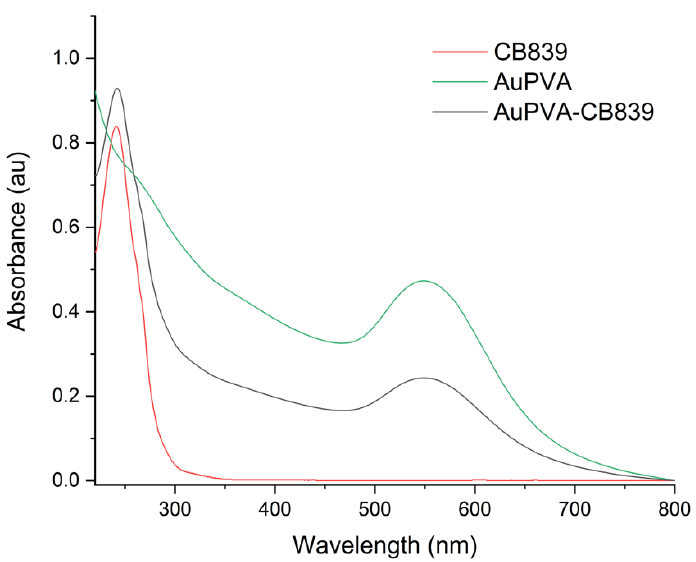
Figure 4. UV-VIS spectra of CB839 (red), AuPVA (green), and AuPVA-CB839 NPs (black). Using energy-dispersive X-ray spectroscopy (EDX), elemental maps of AuPVA- CB839 NPs were collected on a scanning transmission electron microscope (STEM). The elements gold, corresponding to the AuPVA NPs and fluorine from CB839 are displayed in maps in Figure 5. Here, fluorine appears to be in the same area as gold and to form similar circular patterns correlated with the Au map. Since electrons scatter strongly from Au, the contrast in the fluorine (F-K) X-ray map is likely caused by an increase in the Bremsstrahlung background. In order to confirm the presence of F in the vicinity of Au NPs and to observe the influence of background radiation, X-ray spectra taken on Au NPs were compared against such taken from surrounding areas (Figure S7, SM). Figure 5. HAADF-STEM images ( a , b ) and EDX elemental mapping ( c , d ) of AuPVA-CB839 NPs. Gold, corresponding to the NPs is shown in pink and fluorine contained in CB839 in green. From the Au-Mα 1 elemental map (Figure S7a, SM), the inner areas and the edges of NPs were carefully selected (Figure S7b, SM) and three EDX spectra from these scan point subsets were created by averaging all points of a subset (Figure S7c, SM). Since the Au- Mα 1 signal at 2123 eV (red dot, Figure S7c, SM) is strongest on the particles, weaker at edges and absent next to the particles, we believe the threshold values for the assignment to edge and particle interior were chosen correctly. There is no denying that stronger Bremsstrahlung occurs when the electron beam passes through the strongly scattering Au particles, as can be seen in the pure background regions of the spectra, e.g., at 1200–1500 eV. However, all spectra show a slight elevation of the EDX signal at 677 eV (F-K peak, black dot, Figure S7c, SM), independent of location. As AuPVA NPs are surrounded by a